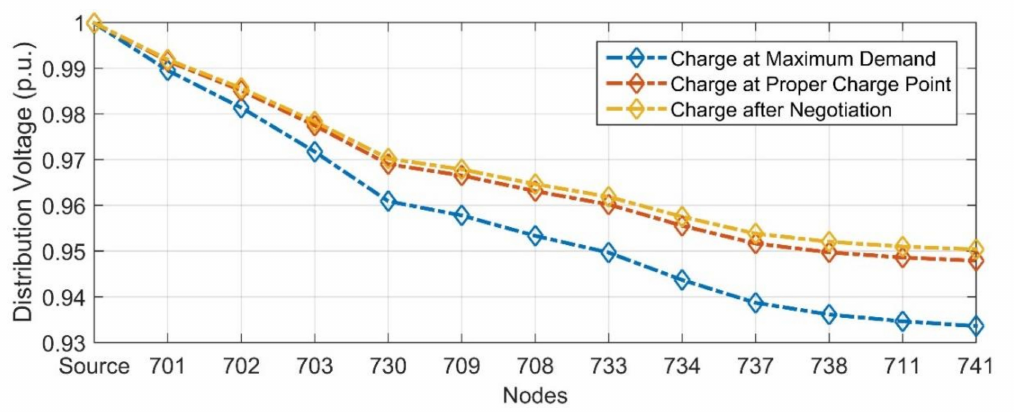
Figure 10. Voltage along the distribution feeder branch in di ff erent charging scenarios at 10:00